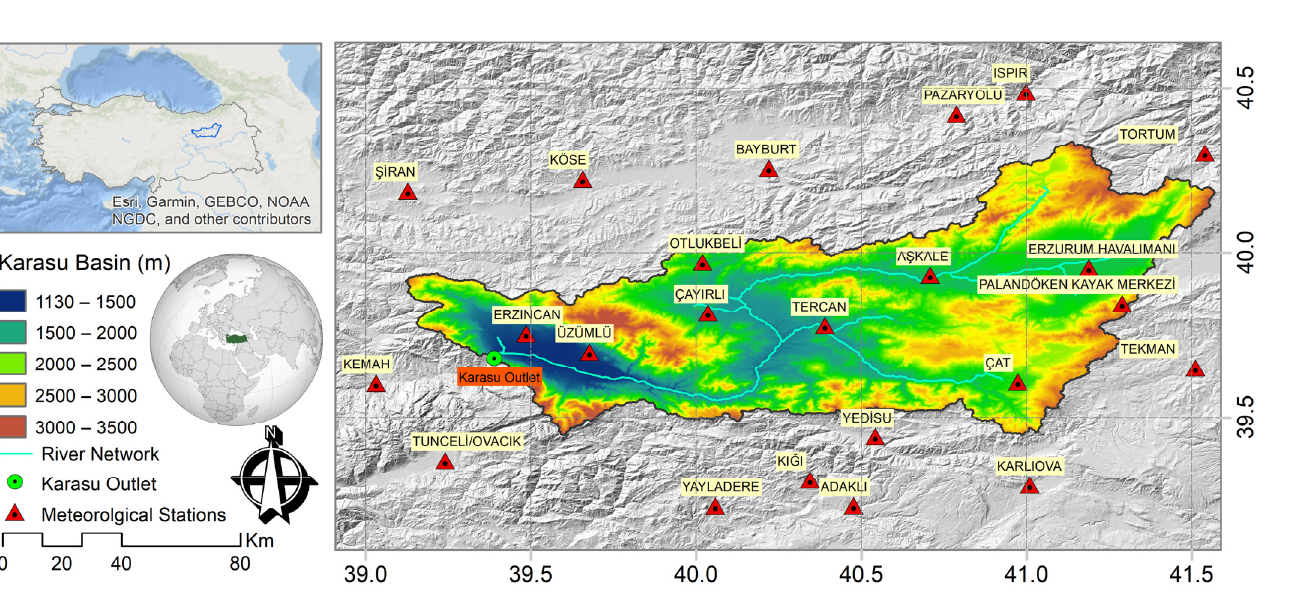
Figure 1. Geographical location, basin topography, and meteorological stations located around the study area.